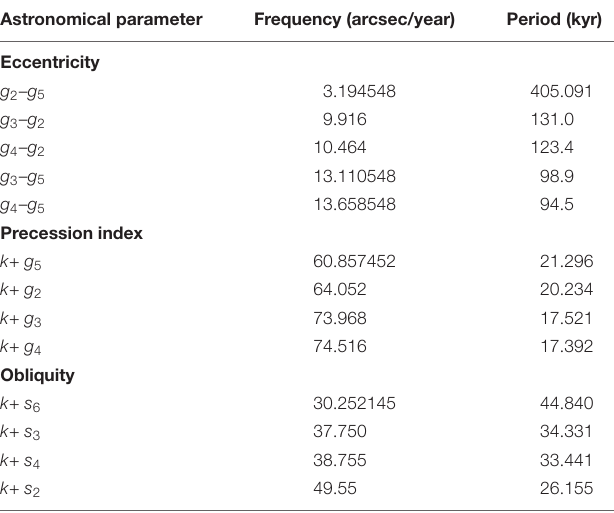
TABLE 1 | Periodicities (in kyr) of orbital eccentricity (from Laskar et al., 2004); precession index, and obliquity are from Earth’s precession frequency ( k ) = 56.6 arcsec/year modeled at 298 Ma (Berger and Loutre,